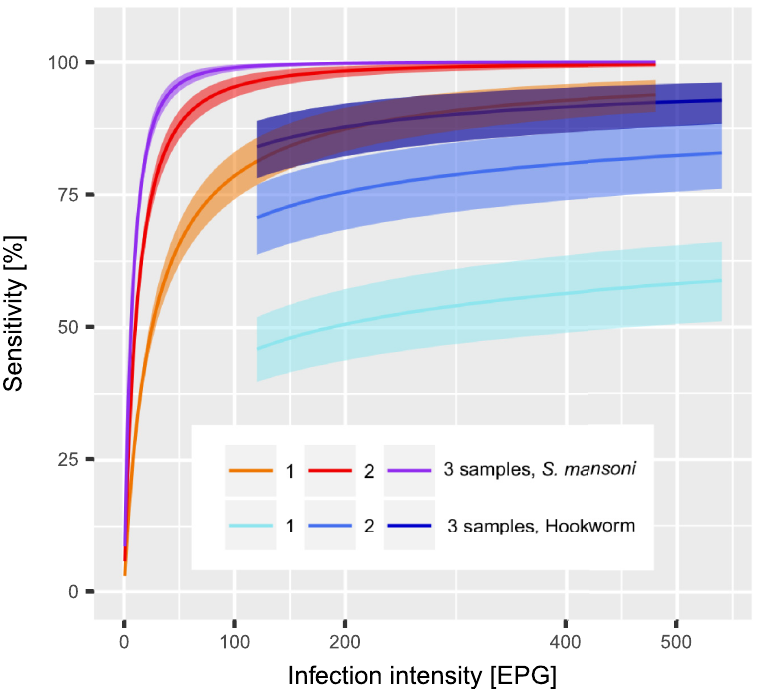
Fig 3. Relation between S. mansoni and hookworm infection intensity with Kato-Katz diagnostic sensitivity, including 95% BCI for k equal to 1, 2, and 3 samples per individual.